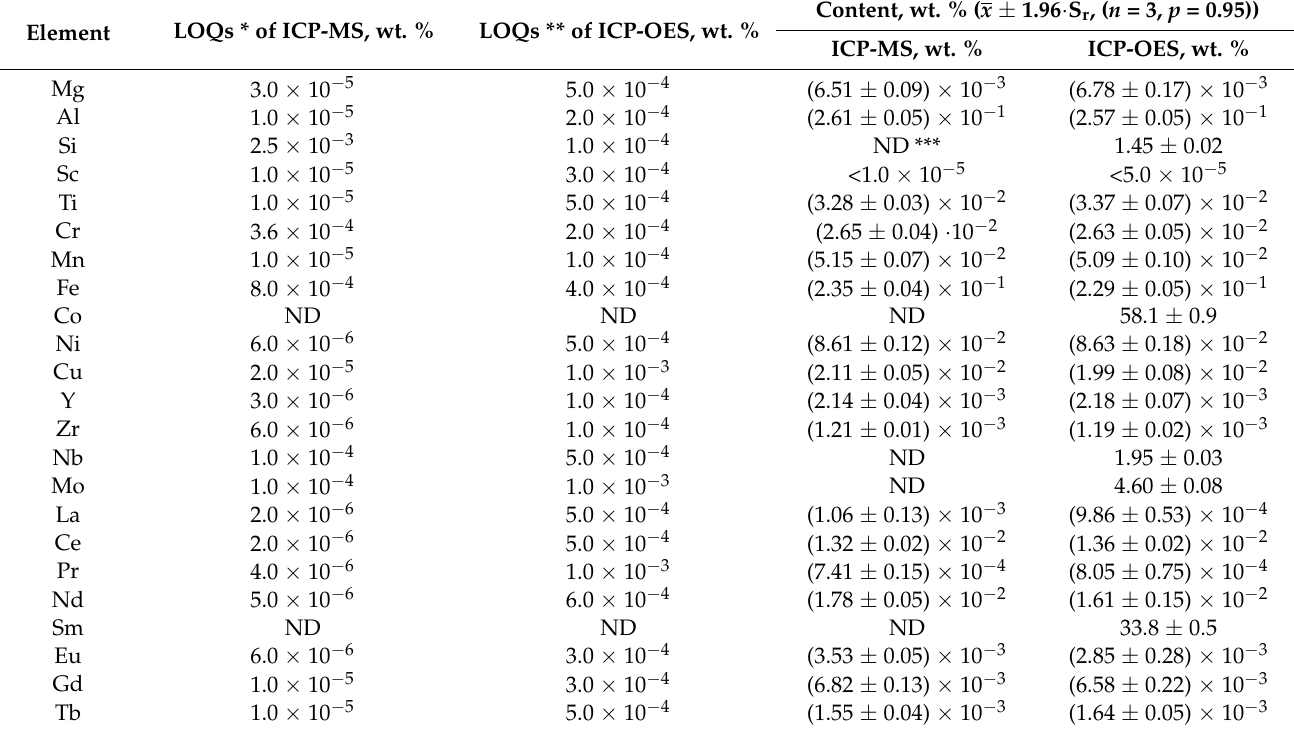
Table 6. Analysis of the reference sample of waste Sm-Co magnets ( n = 3, p = 0.95).